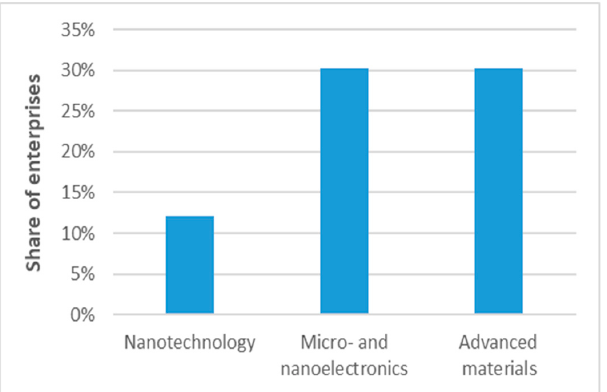
Figure 8. The use of Key Enabling Technologies.